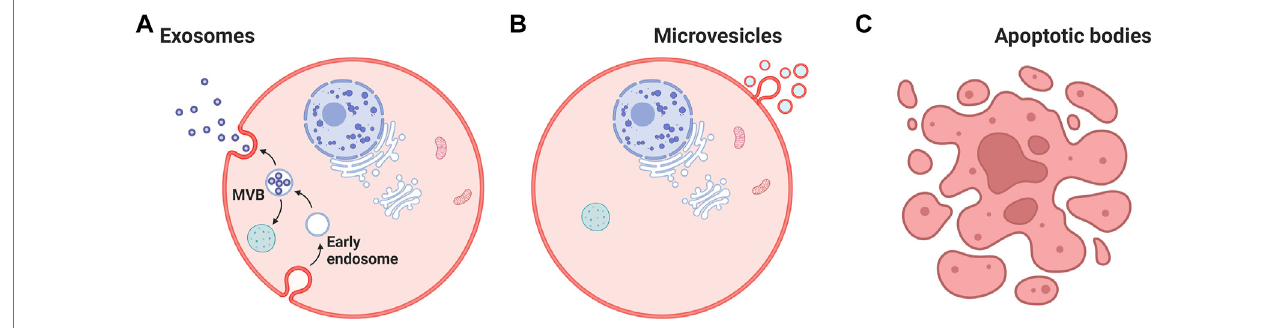
FIGURE 1 | Cell-derived nanovesicles. (A) Biogenesis of extracellular vesicles. (B) Cargoes (Contents) of extracellular vesicles, such as lipids, proteins, miRNA, mRNA, and DNA. (C) Apoptotic bodies. MVB: multi-vesicular bodies. Created with BioRender.com.